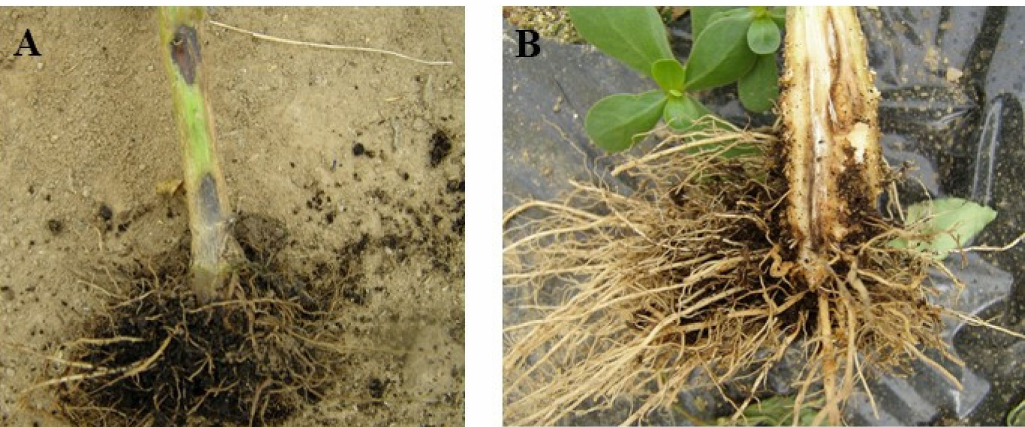
Figure 5. Crown and root rot caused by Fusarium oxysporum f. sp. radicis-lycopersici . ( A ) Necrotic brownish lesions on the stem. ( B ) Adventitious roots on the